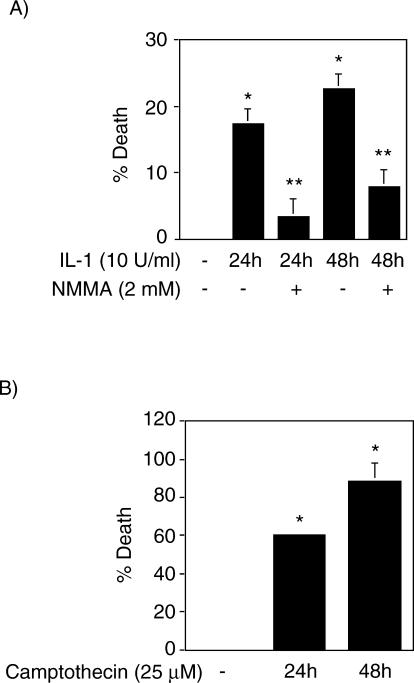
Effects of IL-1 on β-Cell Viability as Determined by Neutral Red UptakeRINm5F cells were treated for 24 h or 48 h with IL-1 (10 units/ml), NMMA (2 mM) (A), or camptothecin (25 μM) (B), and the cells were isolated and percentage of death determined using the neutral red uptake assay. Results are average ± SEM of three independent experiments. *p < 0.05, significantly different from untreated controls. **p < 0.05, significantly different from IL-1-treated condition.